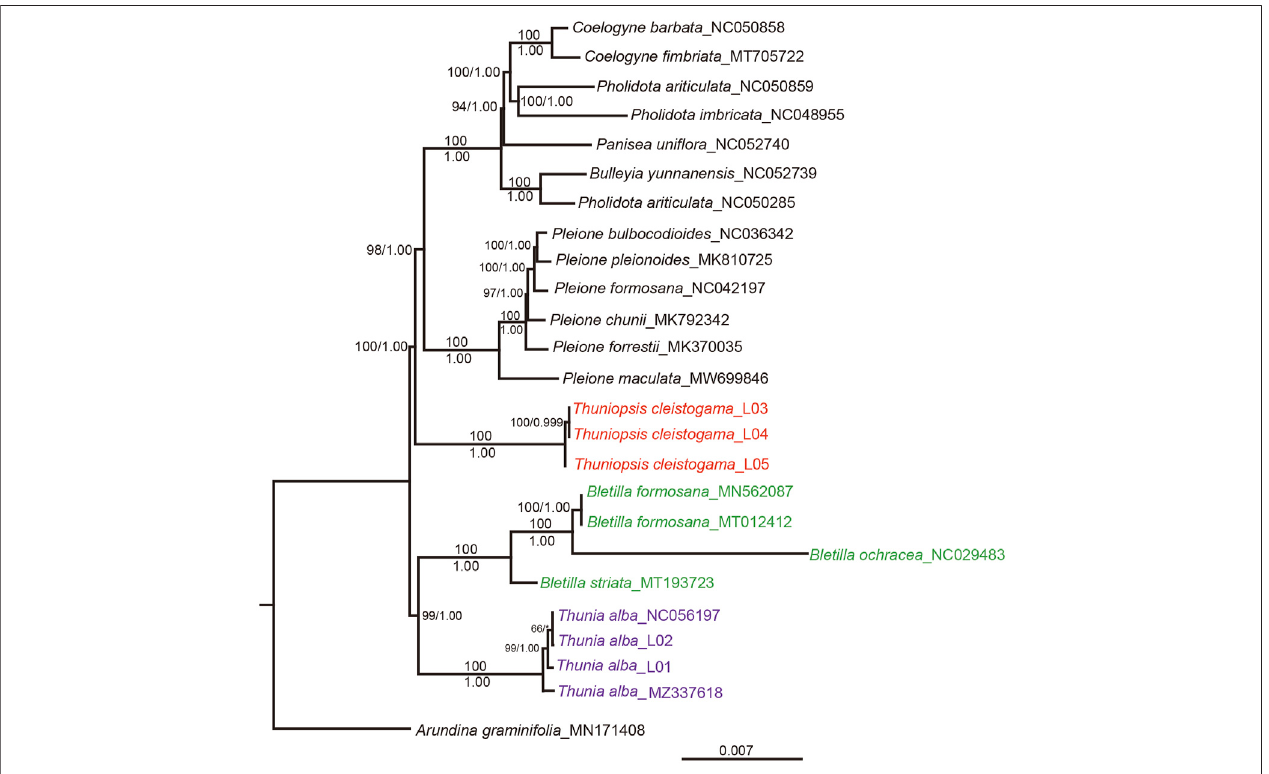
FIGURE9| TheMLphylogenyof Thuniopsis anditscloselyrelatedgenerainsubtribeCoelogyninaebasedoncompleteplastomes.Theobtainedbootstrapvalues (BS) and Bayesian inference posterior probabilities(PP)are marked atthe treenode (BS/PP). Thuniopsis species arehighlighted inred, Thunia speciesare highlighted in purple, and Bletilla species are highlighted in